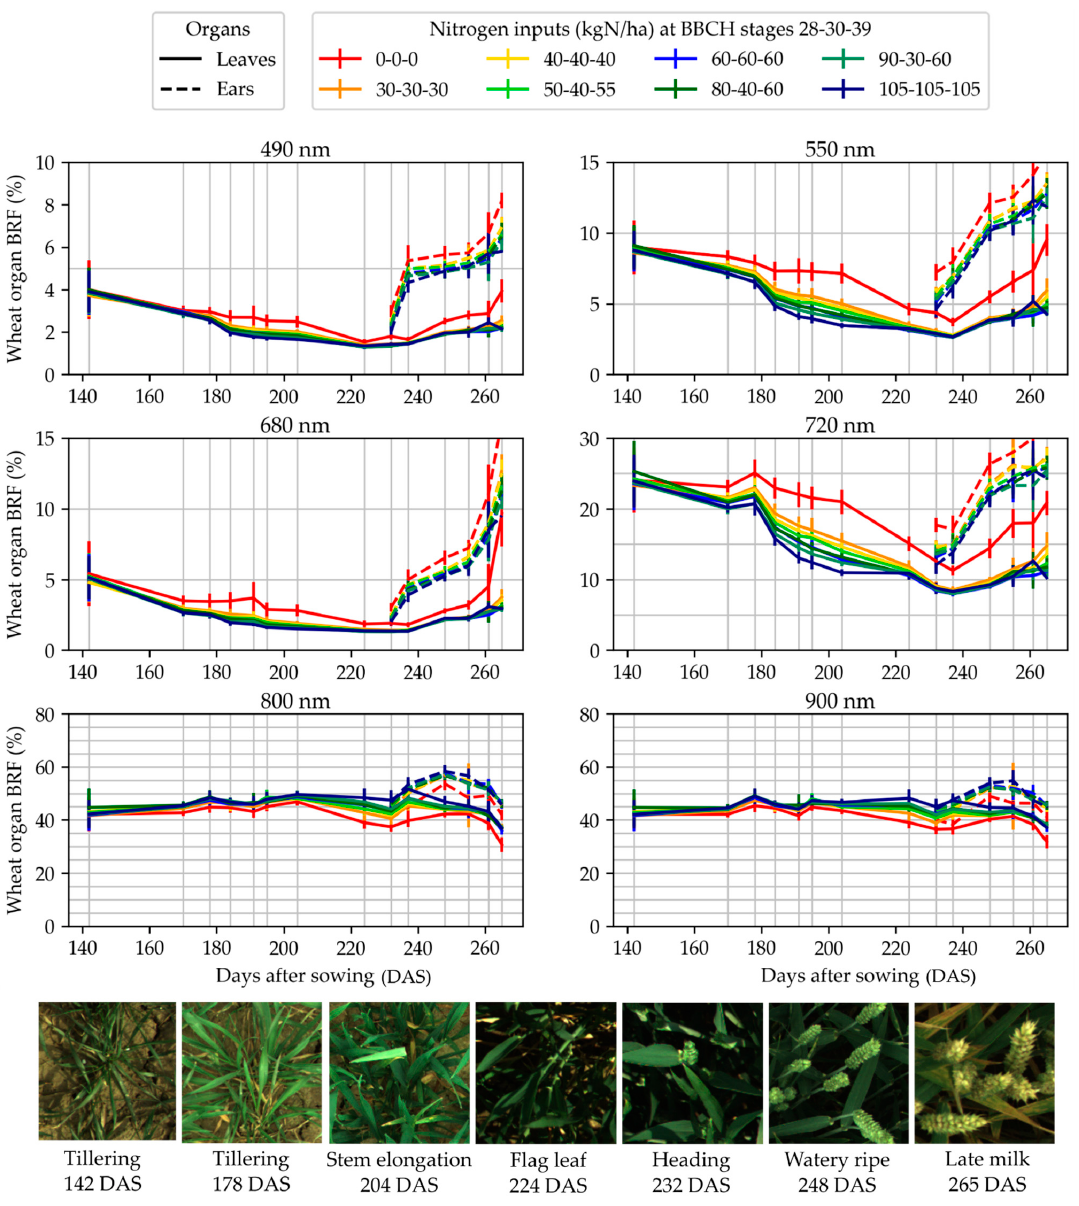
Figure 7. Temporal evolution of the measured bi-directional reflectance factor (BRF) during the measurement campaign in trial 1. The evolution is presented for the six monochrome cameras, designated by the central wavelength of their narrow-band optical filter.